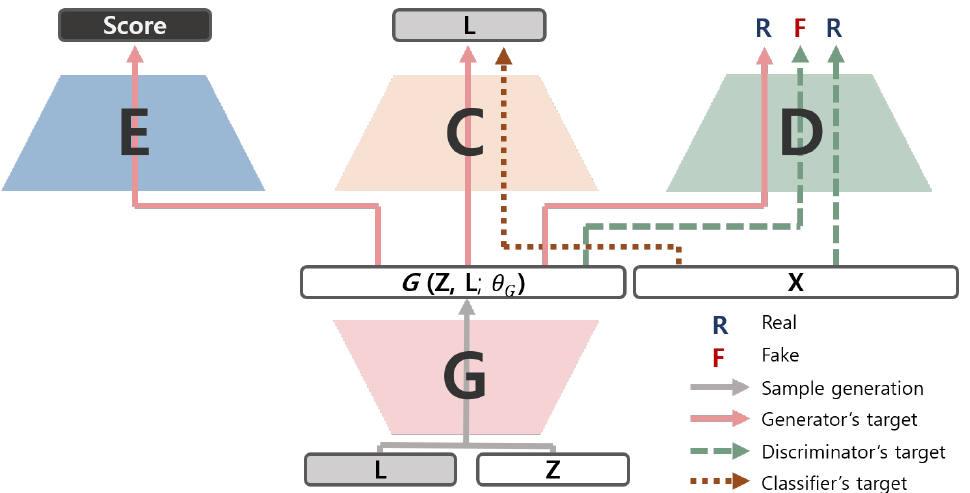
Figure 1. The structure of ScoreGAN.The training of each module is represented with arrows. E: evaluator; C: classifier; D: discriminator; G: